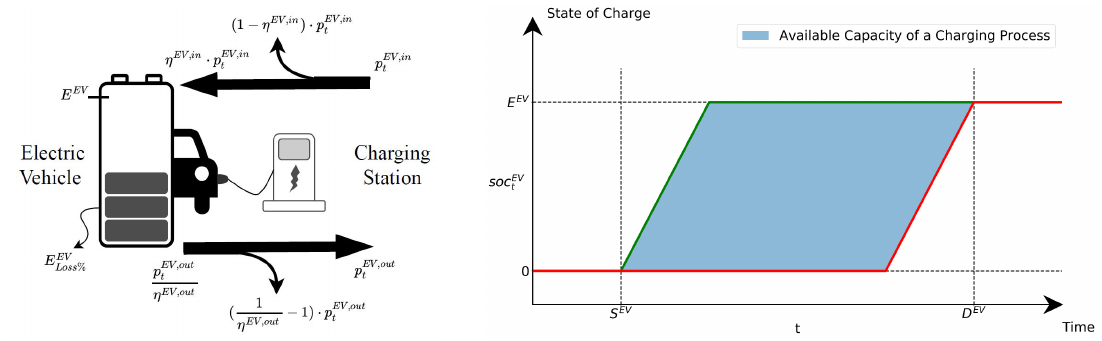
Figure 1. Power flows and available capacity of an electric vehicle during a charging